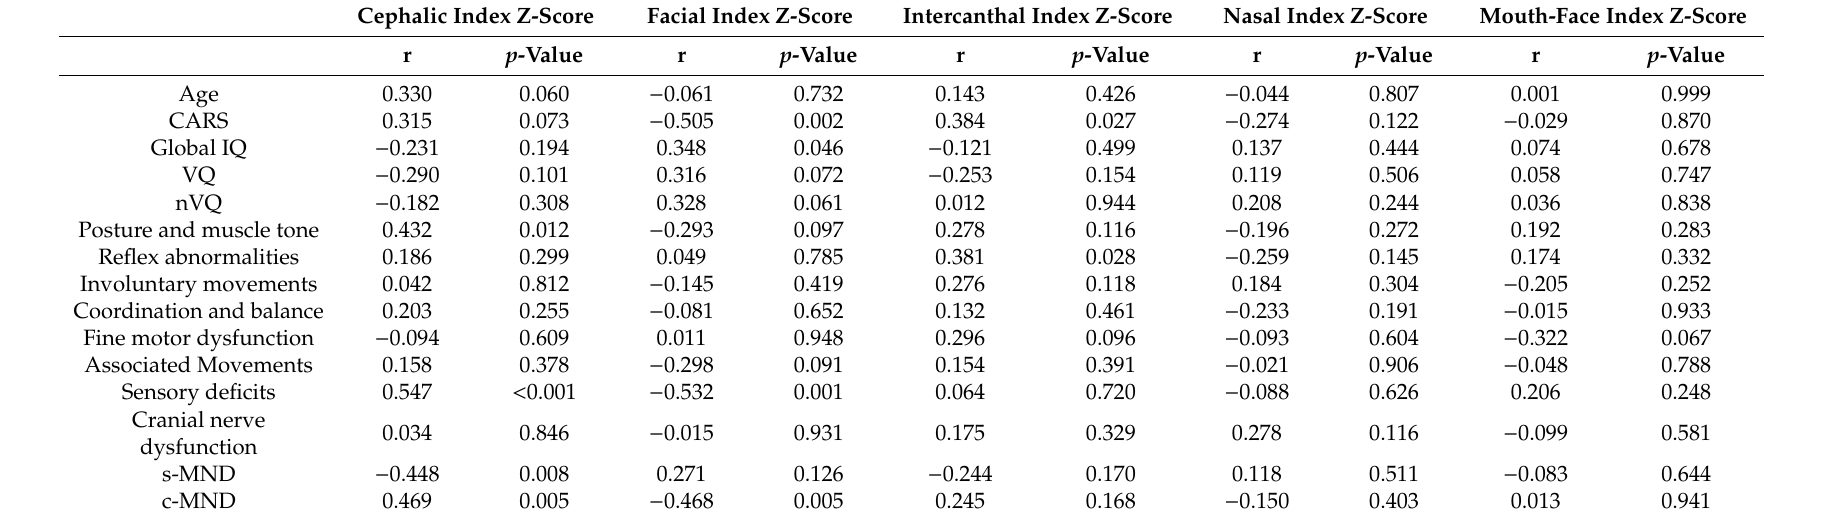
Table 3. Correlations between anthropometric z-scores and age at assessment, CARS, and